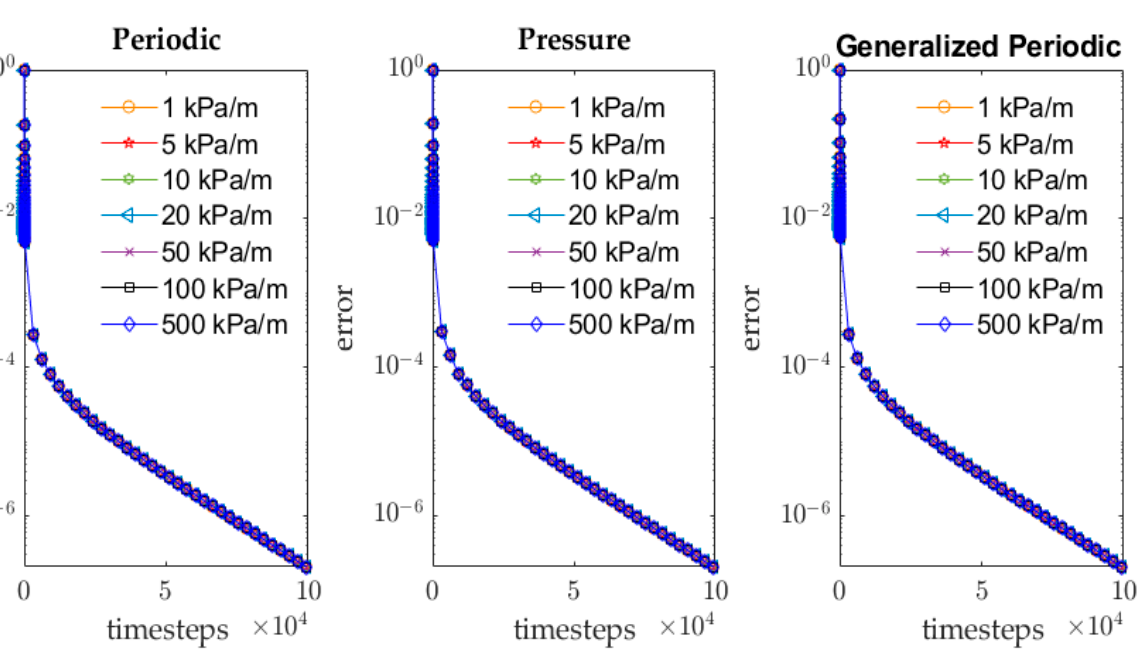
Figure 14. Convergence behavior in domain D2. The convergence behavior in the complex domain D3 (Figure 15) is quite different from those in D2 and seem to converge considerably faster. Table 1 shows the error values at the end of each simulation with the pressure gradient set to 500 kPa/m. Simulations with a periodic boundary condition often converge at the smaller errors.